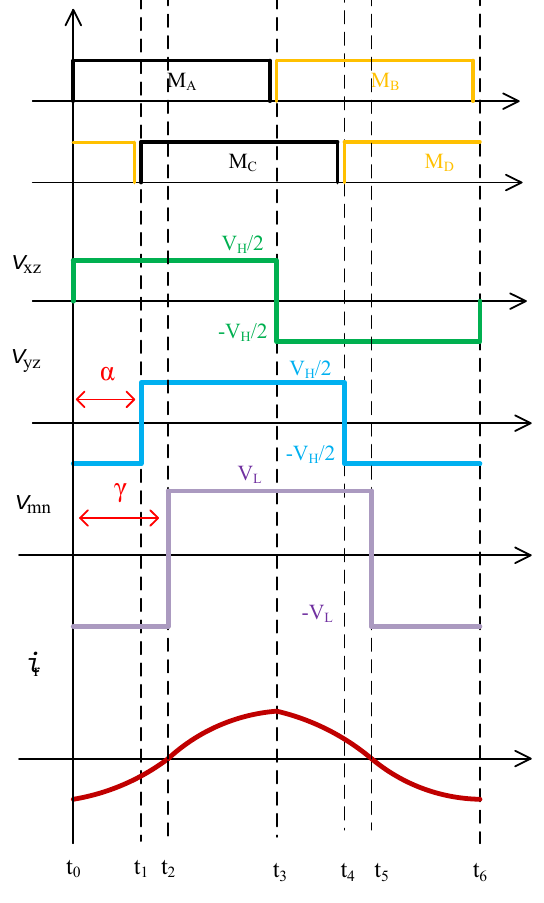
Figure 2. The steady-state operation waveforms of the